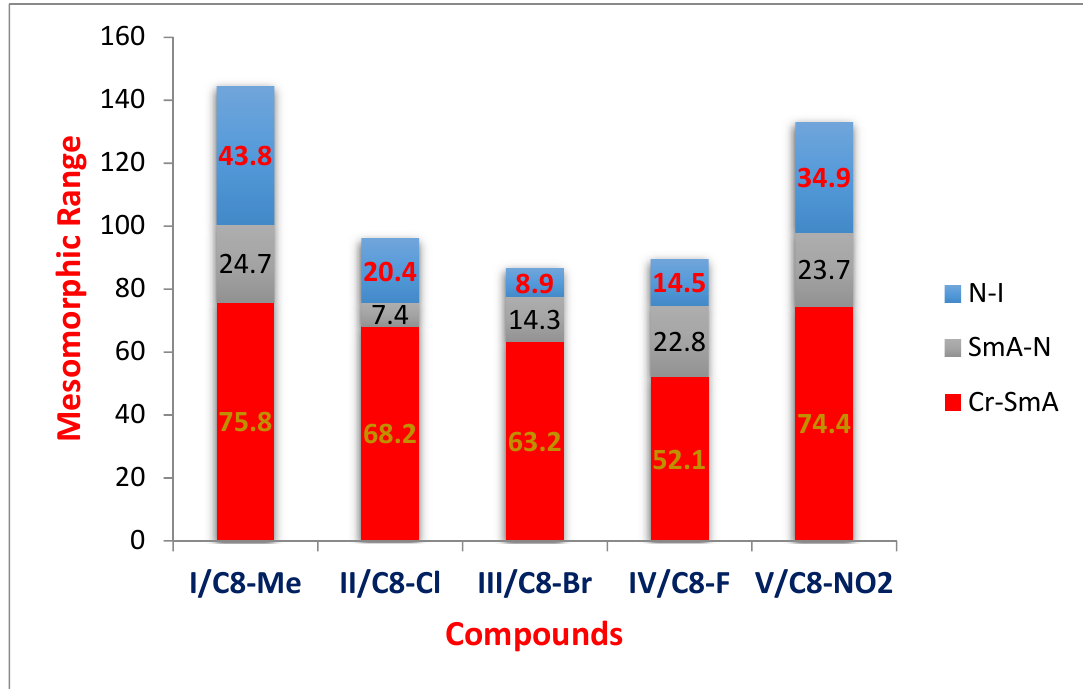
Figure 3. The relationship between the attached polar group and the transition temperatures.